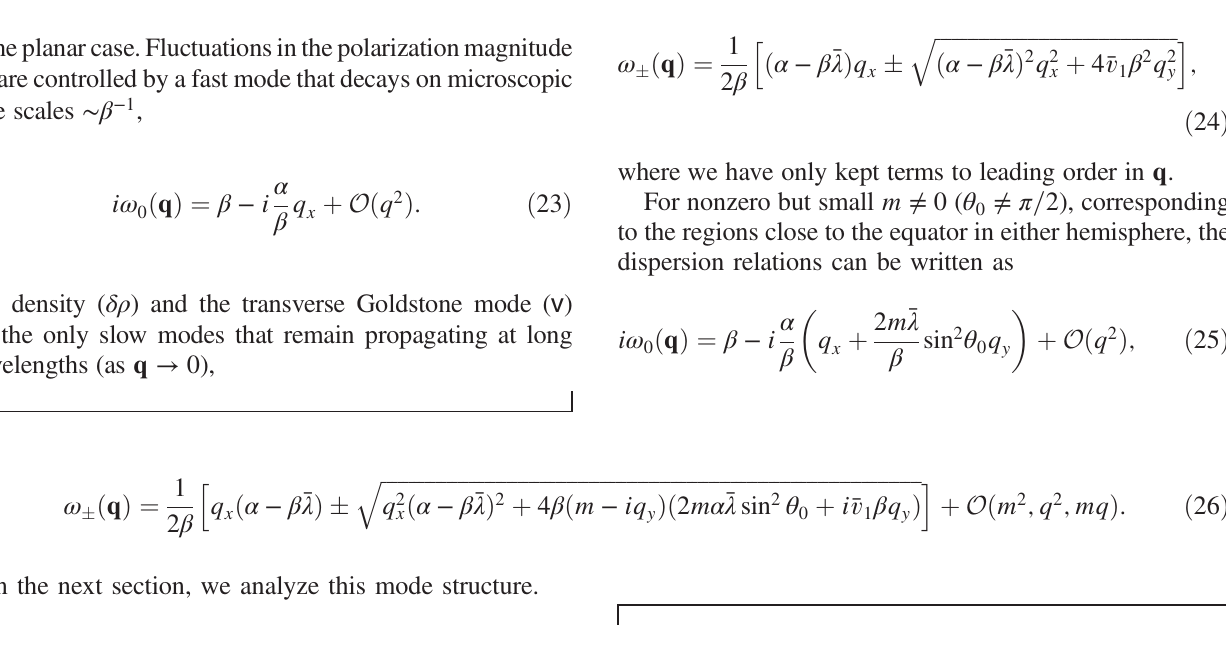
FIG. 3. The relevant (slow) sound modes. (a) m ¼ 0 and the gap between the two bands is closed. Panels (b) and (c) are the dispersion bands for m ¼ 0 . 2 [Eq. (25)], and we directly see that a gap has opened in the real part of the spectrum, while the imaginary part of the 0 . The variables are chosen to be θ ≃ 78 °, α ≃ 2 . 03 , ¯ λ ≃ 1 . 03 , and β ¼ ¯ v 1 frequency has a single crossing line at q 0 1 ¼ y ¼